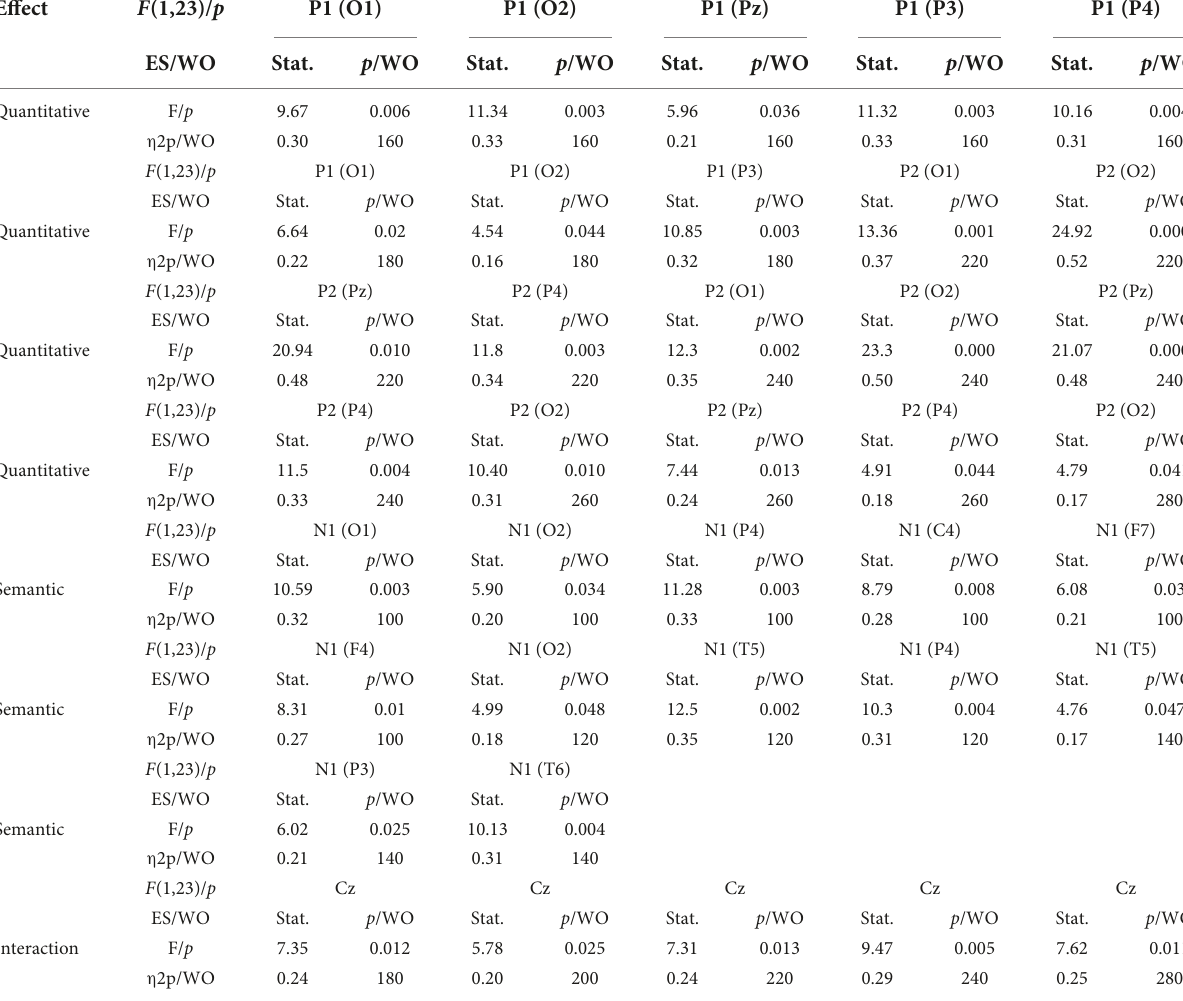
TABLE 6 Significant waveform effects in 19 channels within a 20-ms time window in Experiment 2 ( N =